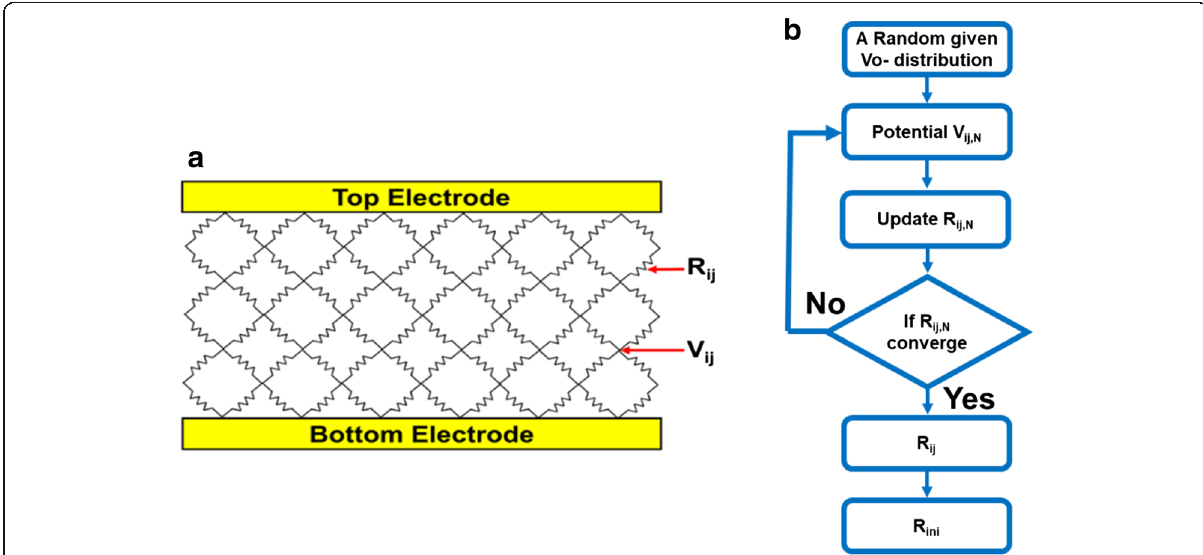
Fig. 4 a Schematic of resistor network model composed by variable localized resistance of Vo-. Nodes in this network are connected to each other to simulate the interaction between Vo-. b Variability simulation flow of initial resistance level. Stochastic distribution of intrinsic Vo- emerge during fabrication is considered by Monte Carlo